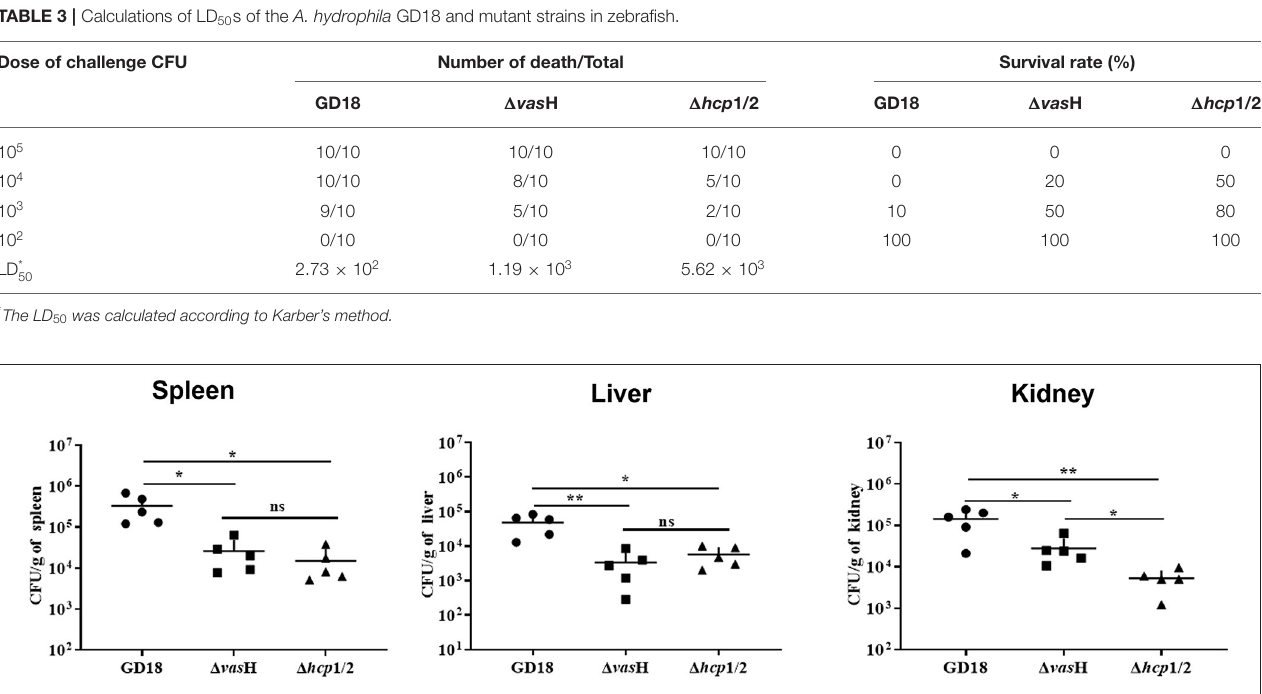
FIGURE 9 | VasH is required for systemic dissemination of A. hydrophila GD18. Grass carp i.p. infected with 2.73 × 10 3 CFU/fish by A. hydrophila were euthanized and dissected 24h post-infection. The data was presented as mean ± SD of five biological replicates from one representative experiment of three independent experiments. Statistical significance was calculated by unpaired t - test. ns, not significant; * p < 0.05; ** p <